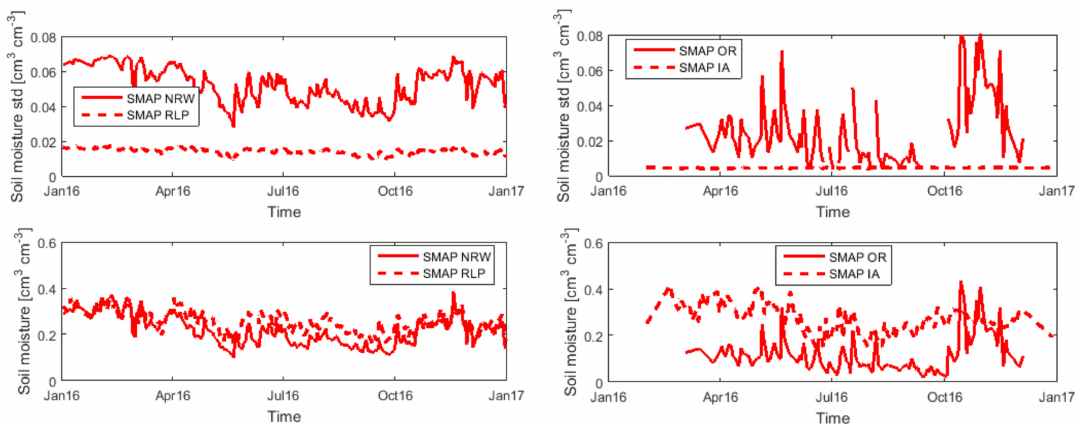
Figure 2. SMAP soil moisture time series for NRW and RLP ( left ) and OR and IA ( right ) including the respective soil moisture standard deviation time